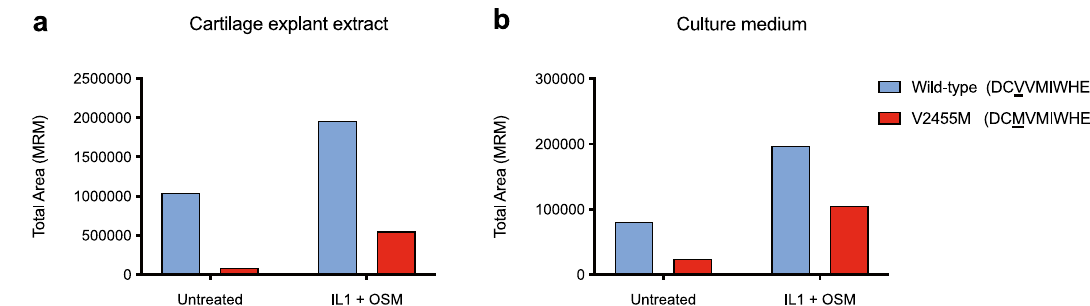
Figure 6. Decreased levels of fOCD variant aggrecan protein in patient cartilage. Cartilage tissue explants from a patient heterozygous for the fOCD-linked p.V2455M ACAN variant were obtained at arthroplasty. Some explants were treated with interleukin-1 and oncostatin M to stimulate protein production. After explant culture, the tissue explants were homogenized and extracted, and conditioned medium was collected. After GluC digestion, wild type and p.V2455M variant-specific peptides were quantified by mass spectrometry (MRM LC-MSMS) in the explant extracts ( a ) and medium ( b ). Note the decreased levels of p.V2455M